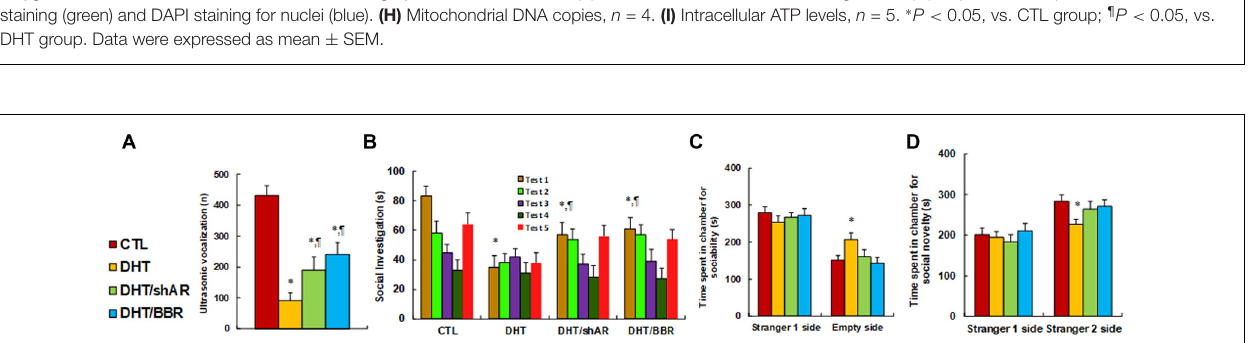
expression of AR, SOD2, and ER β in the amygdala. The results showed that prenatal DHT exposure (DHT) decreased expression of SOD2 and ER β to 51% and 54%, respectively,